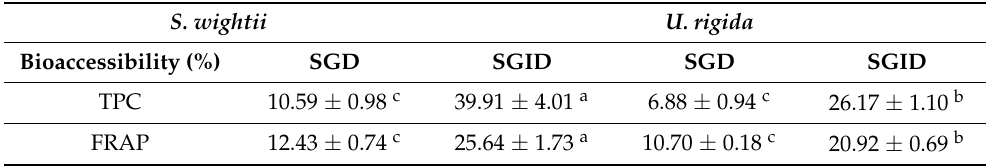
Table 3. Bioaccessibility (%) of macroalgae polyphenols. S. wightii U.